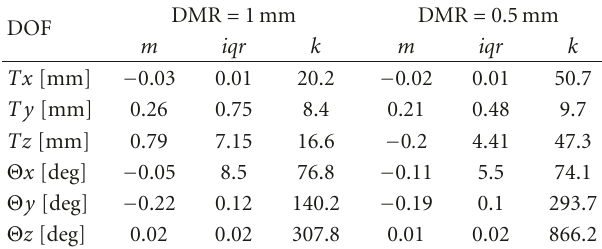
Table 2: E ff ects of the distance map resolution on the pose parameters estimates for the radius